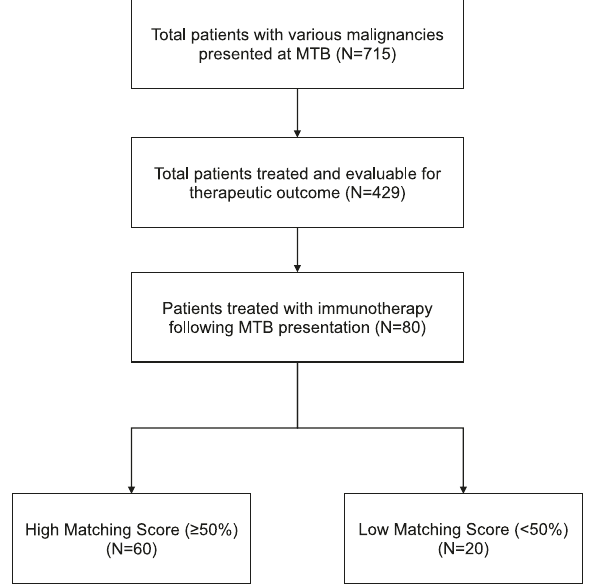
Fig. 1 Consort diagram of patients who presented to the face-to- face Molecular Tumor Board (MTB). Of the total 715 patients with various malignancies that presented to the MTB, there were 80 patients that were treated with immune checkpoint inhibitors and assessable for therapeutic outcome.